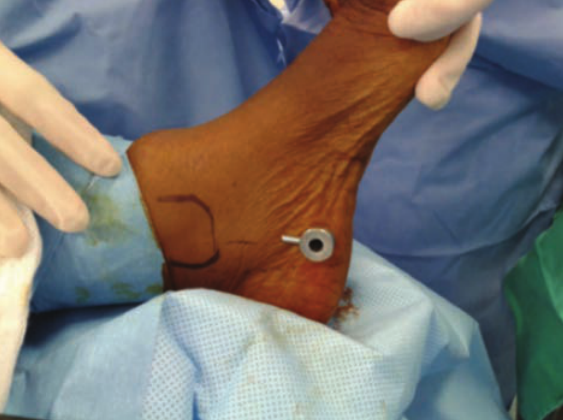
Anatomical landmark for medial portal. Along the midline of medial malleolus and approximately 15mm from plantar surface. Fig. 4: